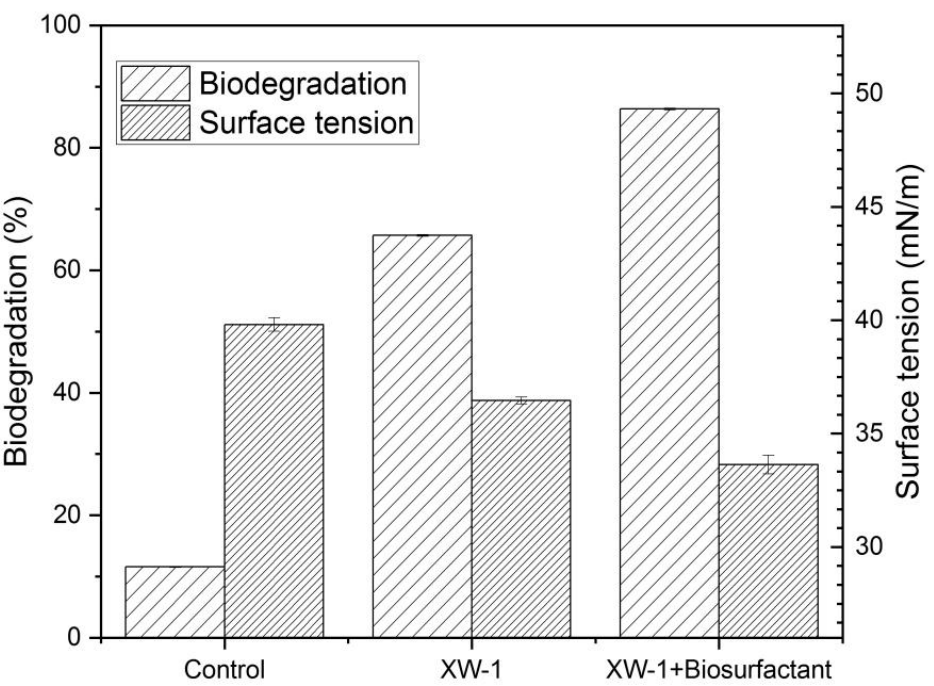
Figure 5. Biodegradation of petroleum in the mixture of sand and water. (1) 25 mL MMC; (2) 25 mL MMC + 1% bacteria; (3) 20 mL MMC + 1% bacteria + 5 mL biosurfactant solution (60 mg/L).